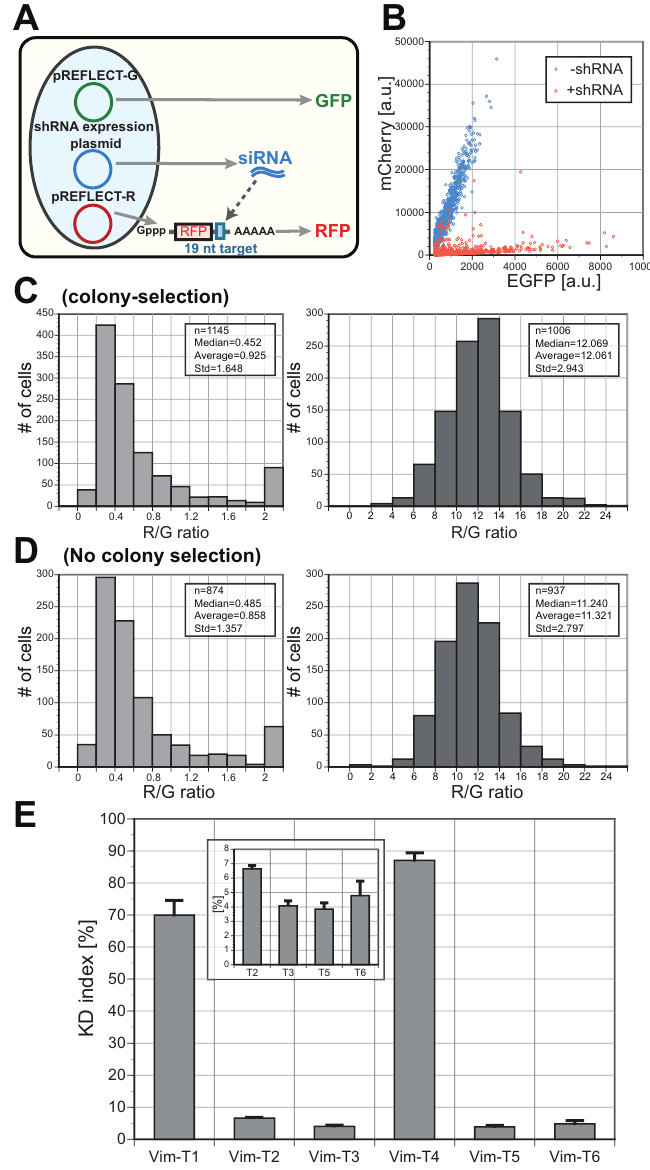
Figure 5. Three plasmid system for dual fluorescence ratiometry. ( A ) We used three plasmids: the shRNA expression plasmid, the pREFLECT-G and the pREFLECT-R. The pREFLECT-G plasmid expresses GFP as a reference, whereas the pREFLECT-R plasmid expresses RFP as a reporter for RNAi. The 3 ′ -UTRs of the GFP and RFP mRNA contain 19-nt scrambled and target sequences, respectively. ( B ) Scatter plots of green and red fluorescence intensities. Rat2 cells were transfected with pREFLECT-G-Ctrl-T1 and pREFLECT-R(mCh)-Vim-T3 with or without pSHIN-Vim-T3. The cells were fixed 24 hr afterwards, and the green and red fluorescence intensities were measured. Whereas the green and red fluorescence intensities were both strong and showed linear correlation without shRNA expression (blue dots), the red fluorescence was significantly suppressed by shRNA expression (red dots). ( C & D ) Histograms of the R/G ratios. The results of co-transfection of pREFLECT-G-Ctrl-T1, pREFLECT-R(mCh)-Vim-T3 with and without pSHIN-Vim-T3 are shown (the left and right histograms, respectively). In C , pREFLECT-R(mCh)-Vim-T3 and pSHIN-Vim-T3 were prepared by the conventional method (the left flow in Figure 4A). The no-selection method (the right flow in Figure 4A) was used for both plasmids in D . Note expanded scale on left histograms demonstrating efficacy of